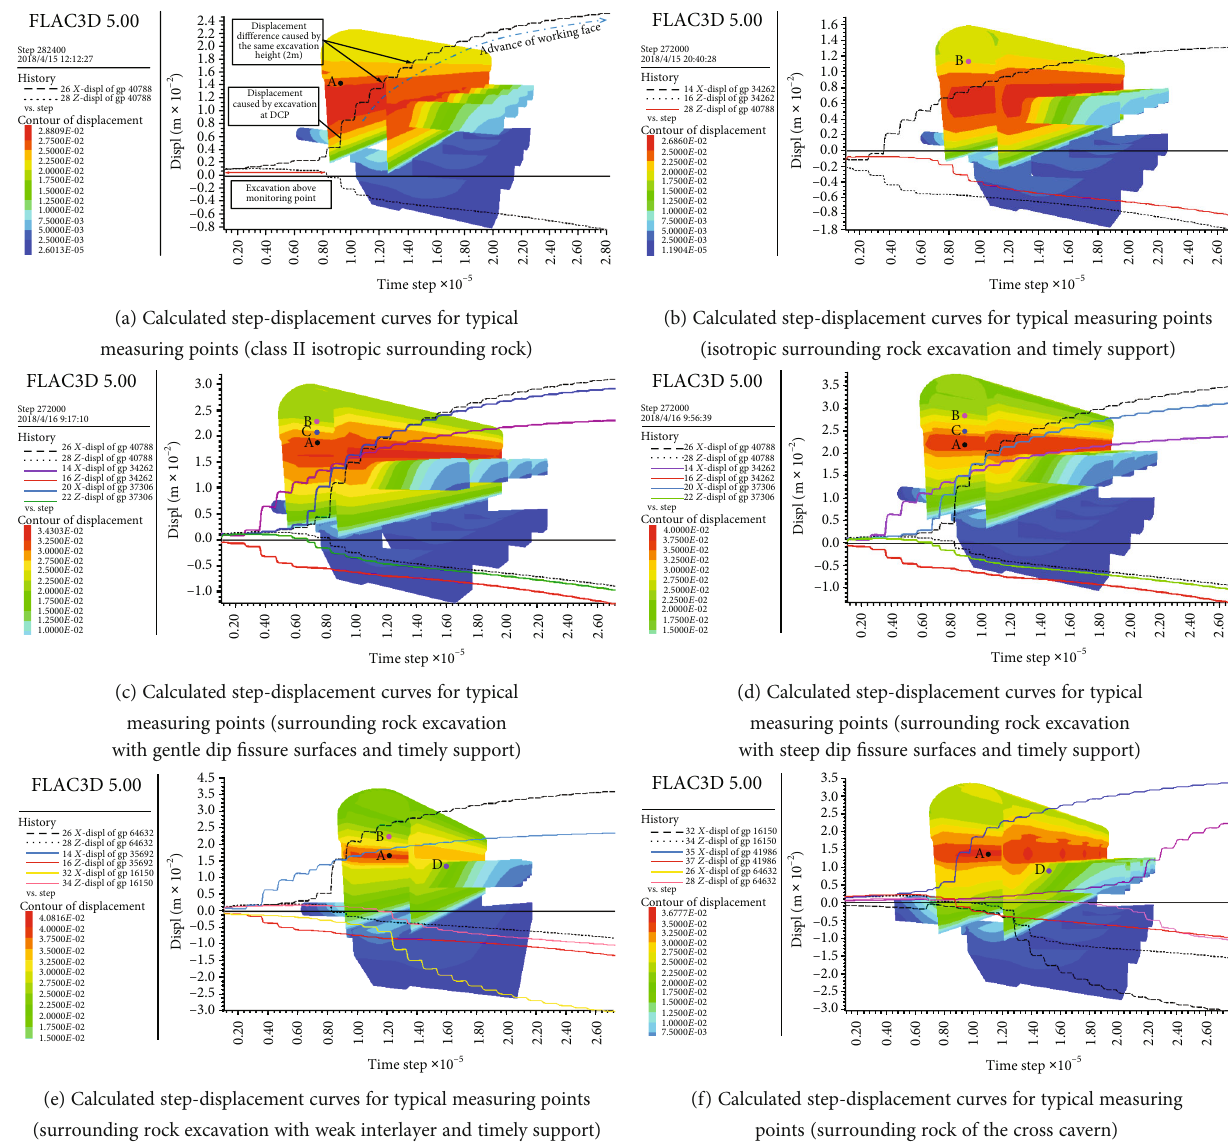
Figure 7: Numerical simulation results of representative monitoring